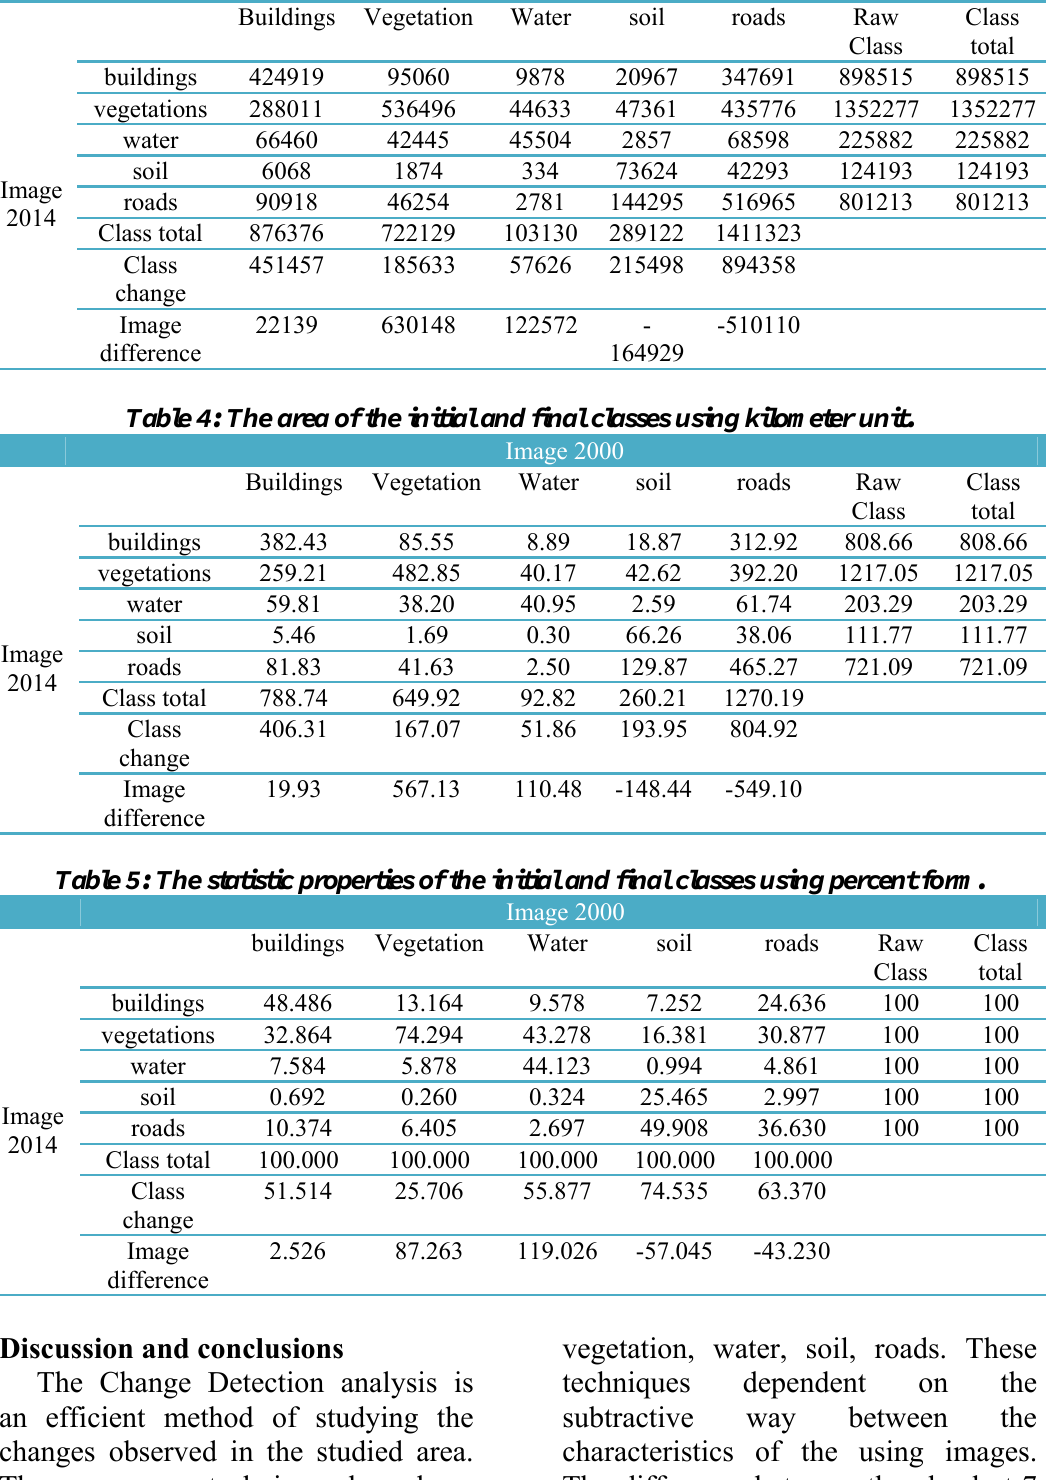
Table 3: The statistic properties of the initial and final classes using pixel unit. Image 2000